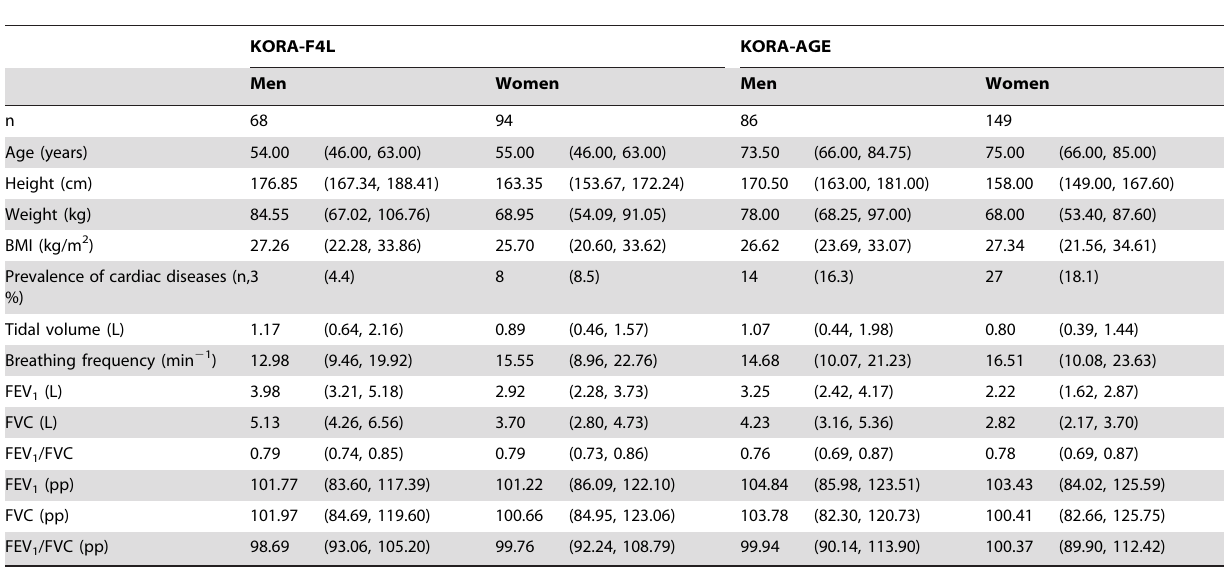
Table 1. Descriptive data of the samples from KORA-F4L and KORA-AGE, median (5th, 95th percentile).